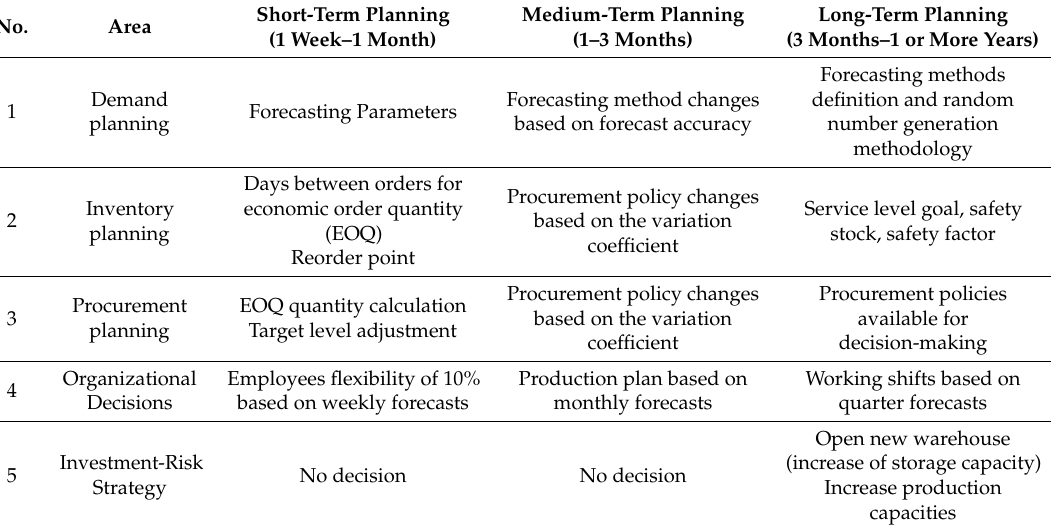
Table 1. Planning decisions in the market-oriented procurement model (own elaboration).